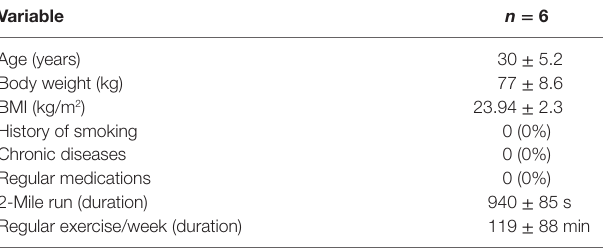
TaBle 1 | Characteristics of the study